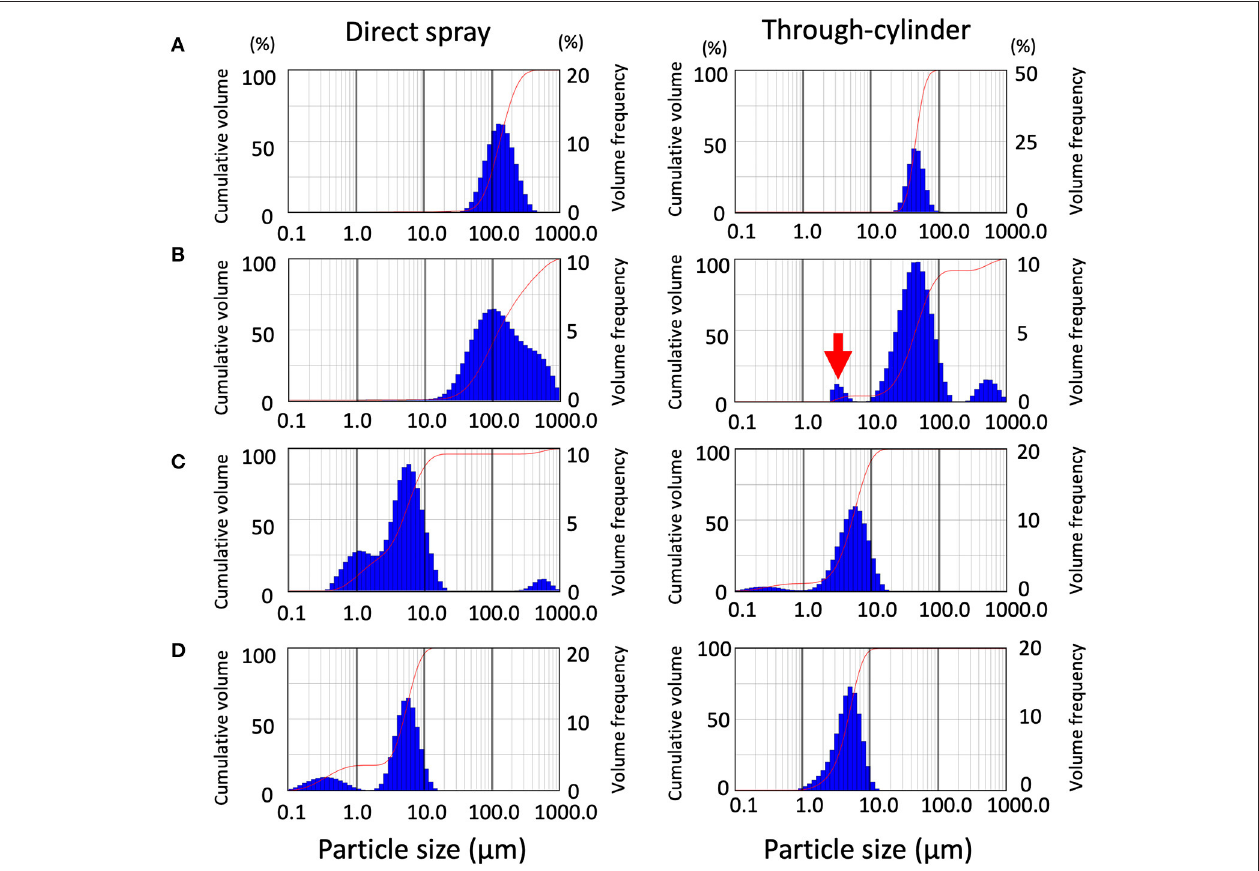
FIGURE 2 | Distribution patterns of droplet size emitted from the devices and validation of the removal effect of the cylinder on large droplets. In each data set, data from direct spraying (left), and through-cylinder (right) are shown separately. Droplet size distribution (DSD) histogram graph emitted from ultrasonic scaler (A) , 3-way syringe (B) , nebulizer (C) , humidifier (D) . The curve in the graphs represent the droplet cumulative volume frequency and the percentage of a particular size of the droplet. Each experiment was performed independently at least four times, and the results of one representative experiment are shown.